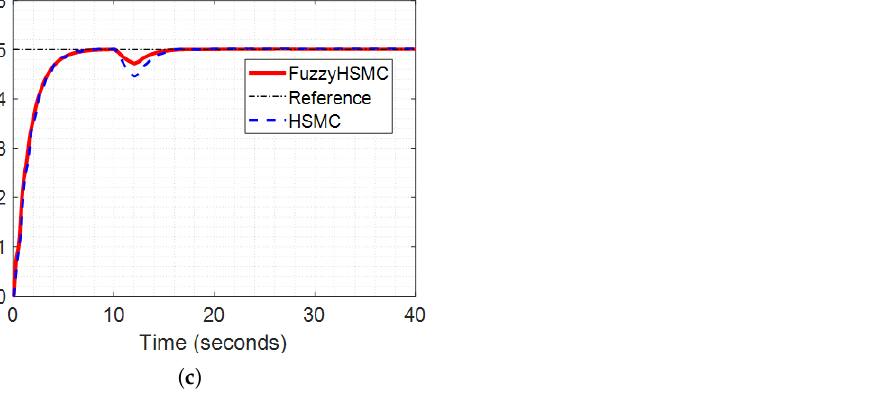
Figure 9. The actuated states under the external disturbances. ( a ) The trolley position x ( t ) . ( b ) The bridge position y ( t ) . ( c ) The pulley angle θ ( t ) .